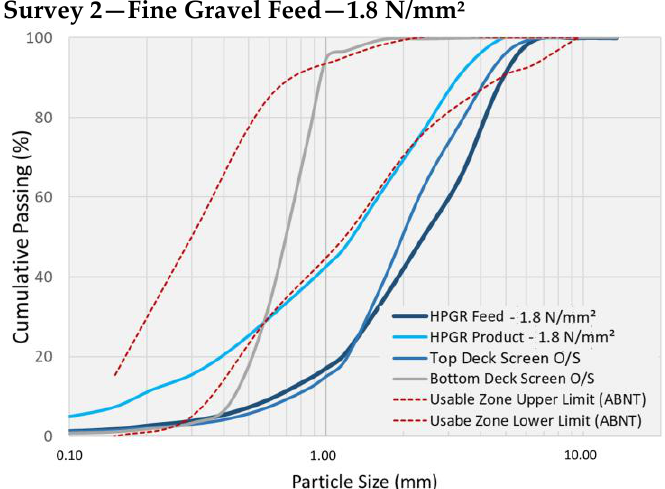
Partially Within the limits of the Outside the limits of